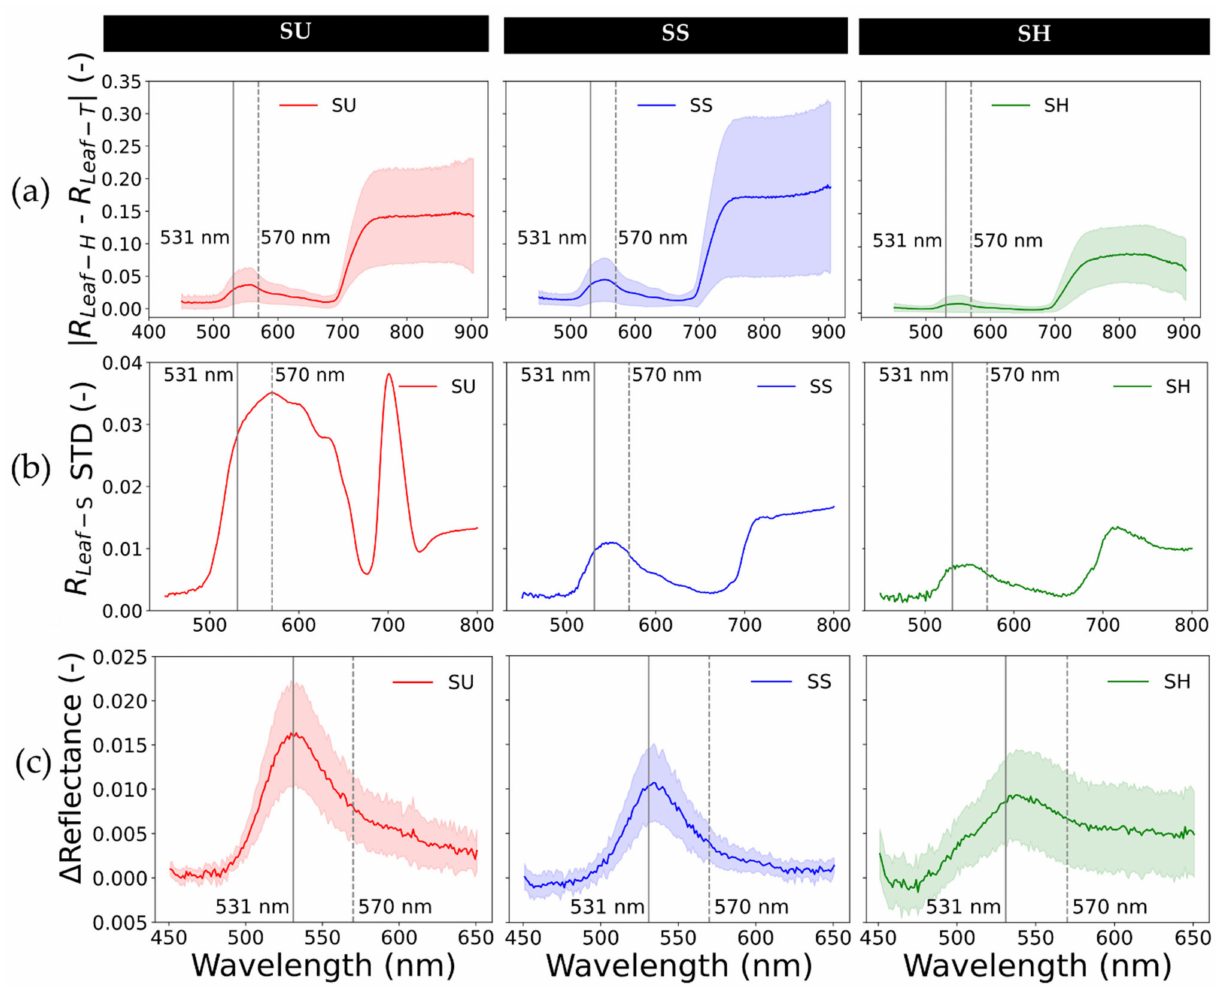
Figure 12. Spectral variability due to structural, biological (or seasonal-like) and quick photochemical effects. ( a ) The first row is related to the structural effects and indicates the absolute difference in the reflectance value for the data illustrated in Figure 6. ( b ) The second row (R Leaf-S STD) shows the reflectance’s standard deviation from the measurements acquired with the integrating sphere, representing the intrinsic variability inside the plant. ( c ) The difference in reflectance between the beginning and the end of the transient during light adaptation, indicative for the quick photochem- ical changes, calculated as the difference between the first (t = 0 min) and the last (t = 24.5 min) measurement of each